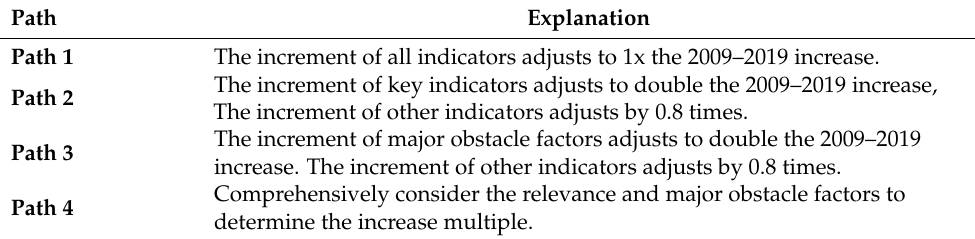
Table 9. The coordinated regulation